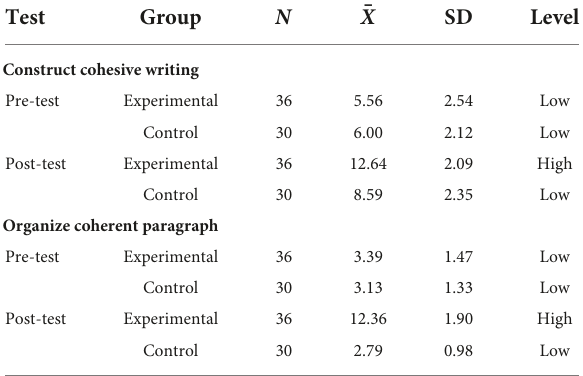
TABLE 1 Level of students’ ability to construct cohesive writing and organize coherent paragraph before and after exposure to concept mapping